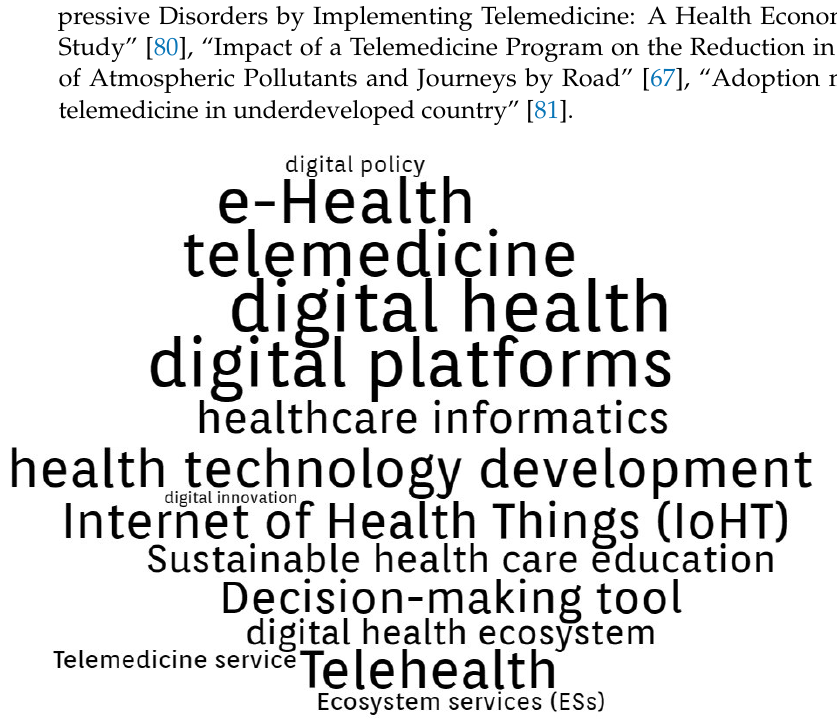
Figure 6. Digital Transformation cluster Authors’ Keywords.